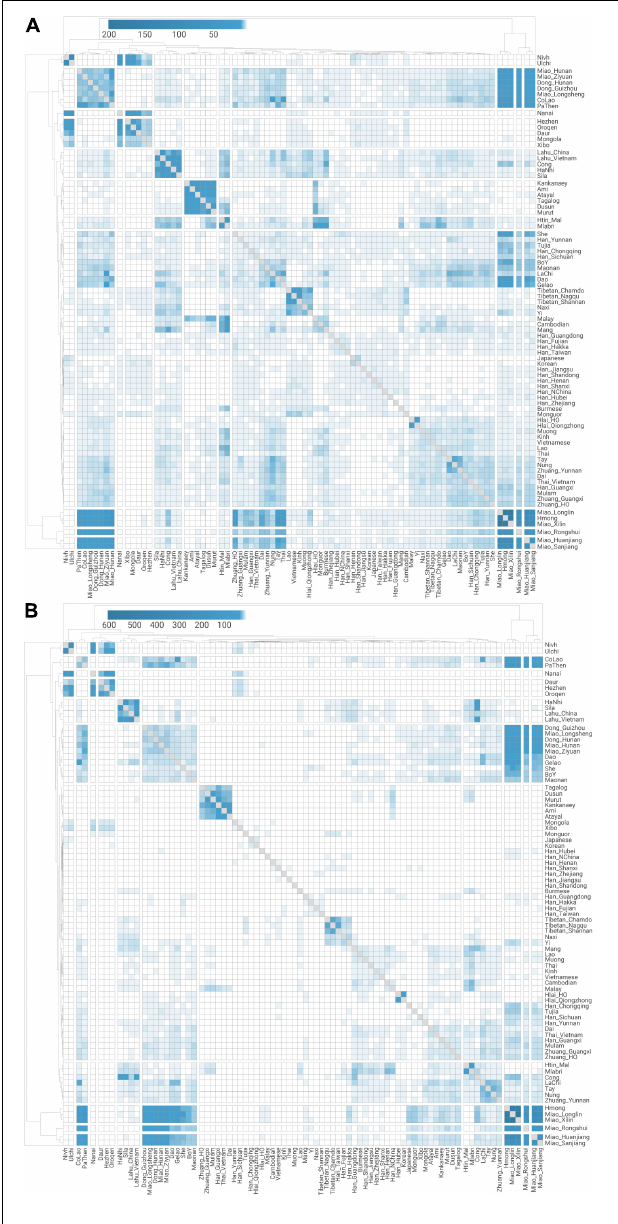
FIGURE 3 | Quantitative measurement for pairwise genetic affinity based on haplotype sharing. Normalized haplotype sharing based on (A) the number and (B) the total length (unit: cM) of shared identity-by-descent chunks for pairwise modern East Asian populations.